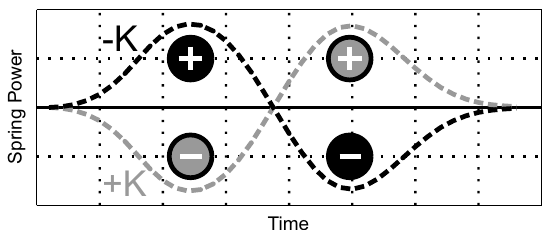
Figure 8. Power curves for positive (+K) and negative (–K) stiffness when a load is applied. Because negative stiffness cannot be realized by an SEA, the corresponding results were neglected. In these cases, a rigid direct drive resulted in the smallest energetic requirements (Table